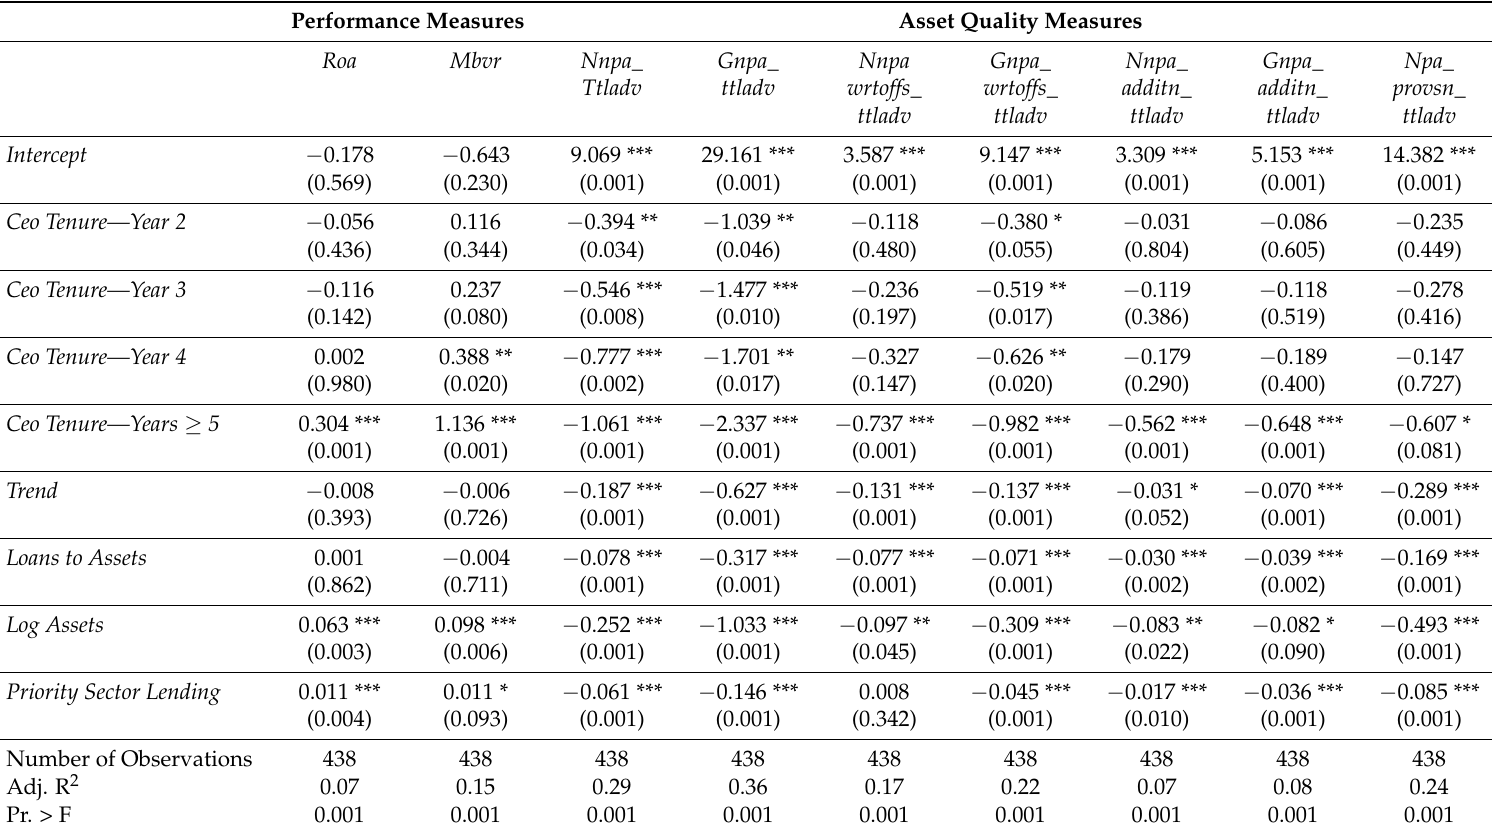
Table 9. CEO Tenure and Bank Performance: Year-wise